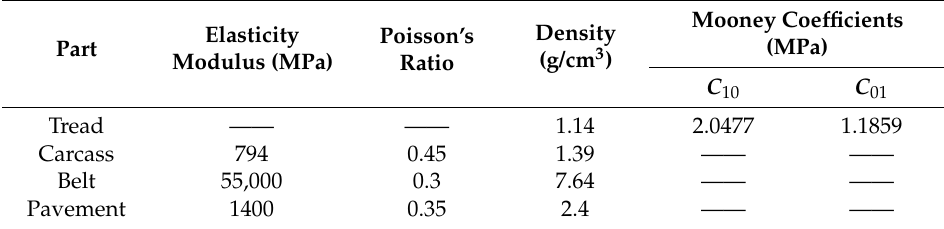
Table 1. Material properties of the tire and